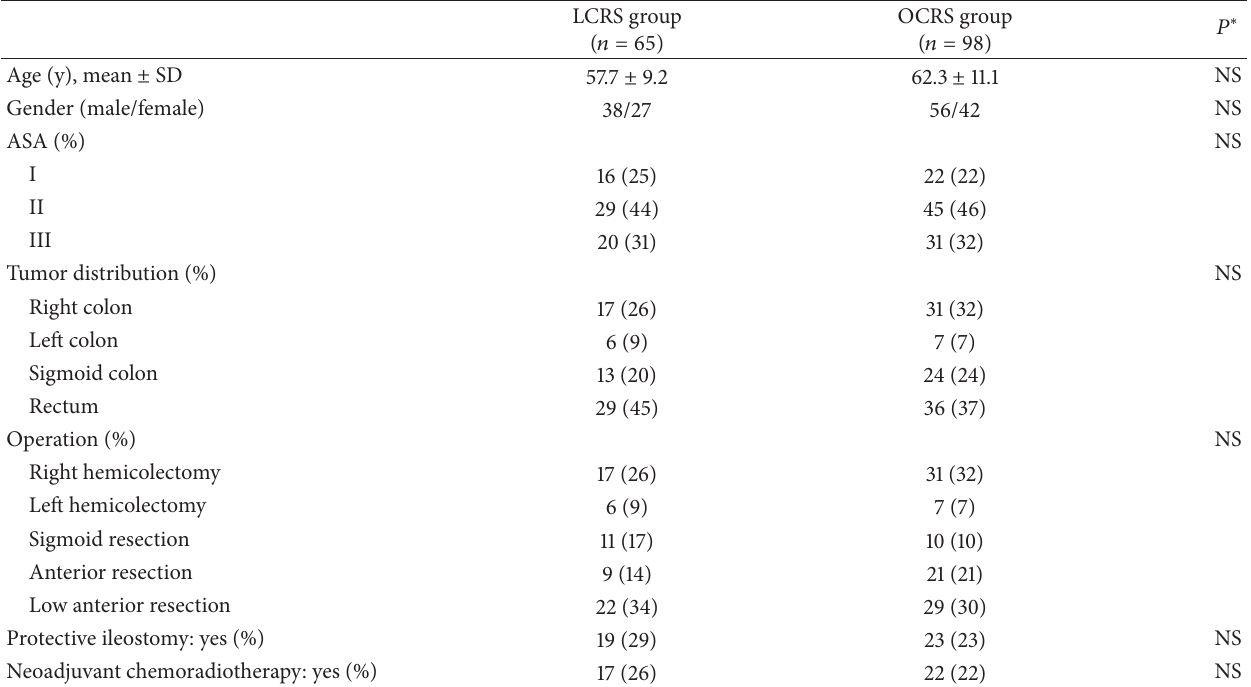
Table 1: Patient and tumor characteristics.